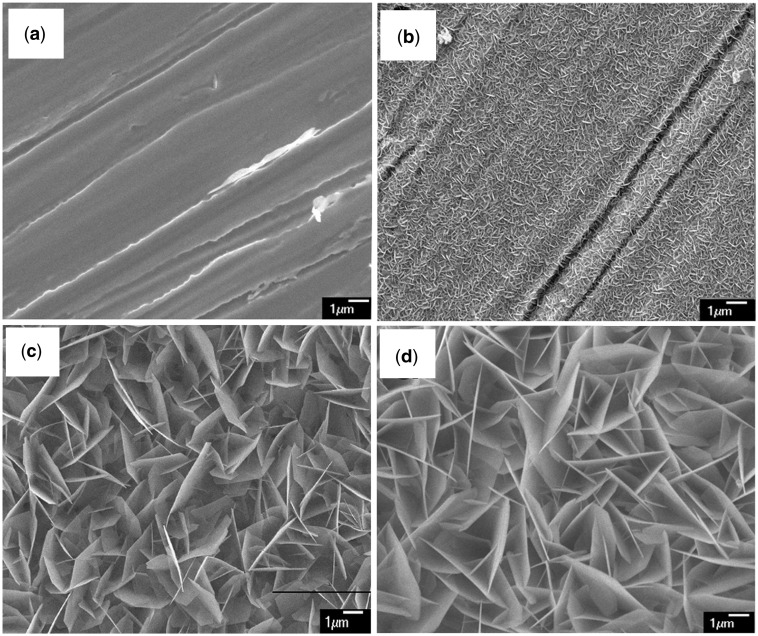
 SEM morphologies of the surface of Co-Cr alloy (a) control substrate after etching by mixed acid, (b) after alkali-treatment, (c) immersion in BMS for 12 h (d) then incubation in SD solution for 12 hours.